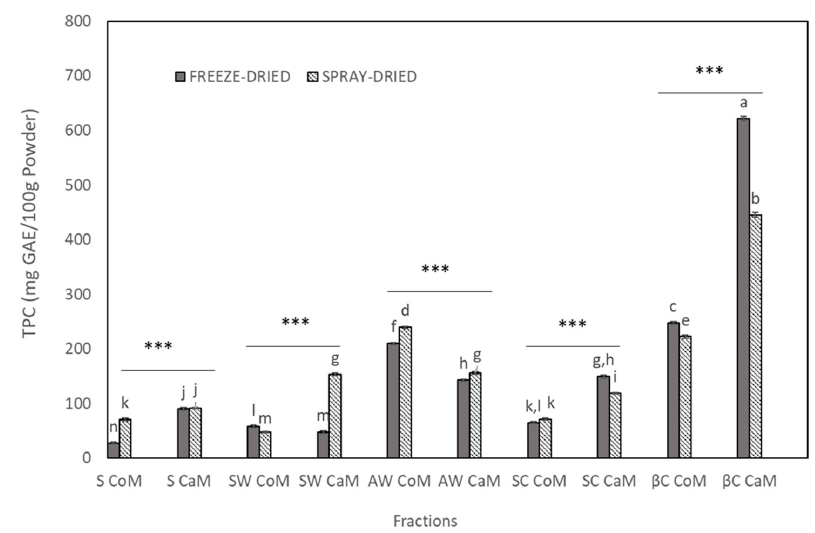
Figure 2. Total phenolic contents of non-irradiated freeze-dried and spray-dried cow and camel milk